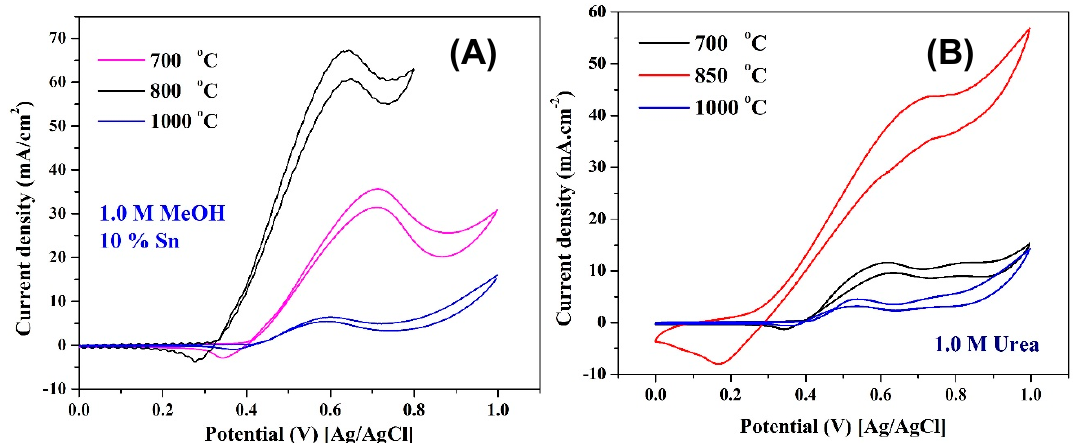
Figure 11. Influence of calcination temperature on the electrocatalytic activity of 10 wt % Sn nanofibers toward oxidation of methanol (1.0 M in 1.0 KOH) ( A ) and urea (1.0 M in 1.0 KOH) ( B ); the measurements were performed at room temperature and a scan rate of 50 mV/s.